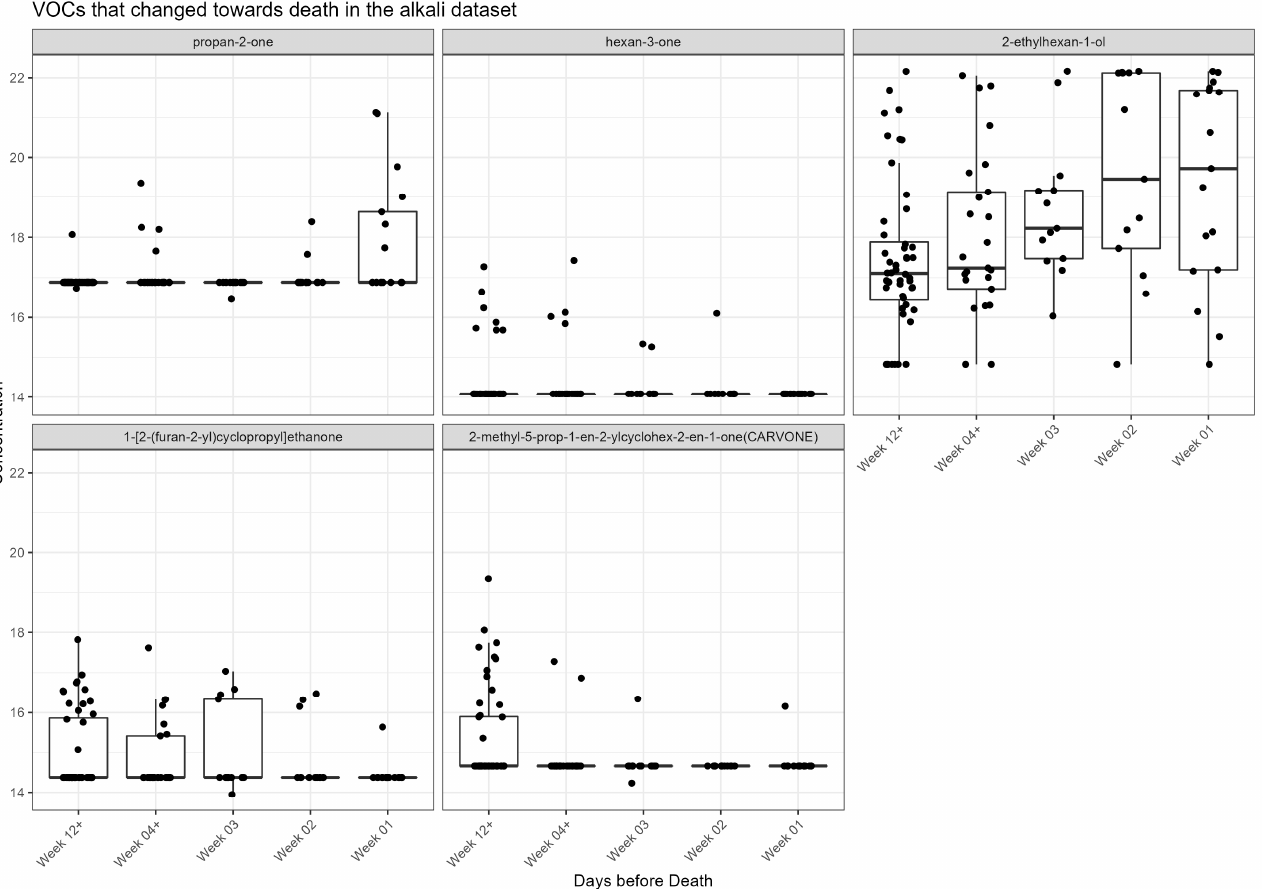
Figure 5. VOCs that change towards death in the alkali dataset. Jitter box plot graph for each metabolite identified as significant from univariate and linear regression analysis. The centre line is the median; box limits are upper and lower quartiles; whiskers are 1.5× interquartile range; points are individual observations. Y axis is VOC concentration on glog scale.